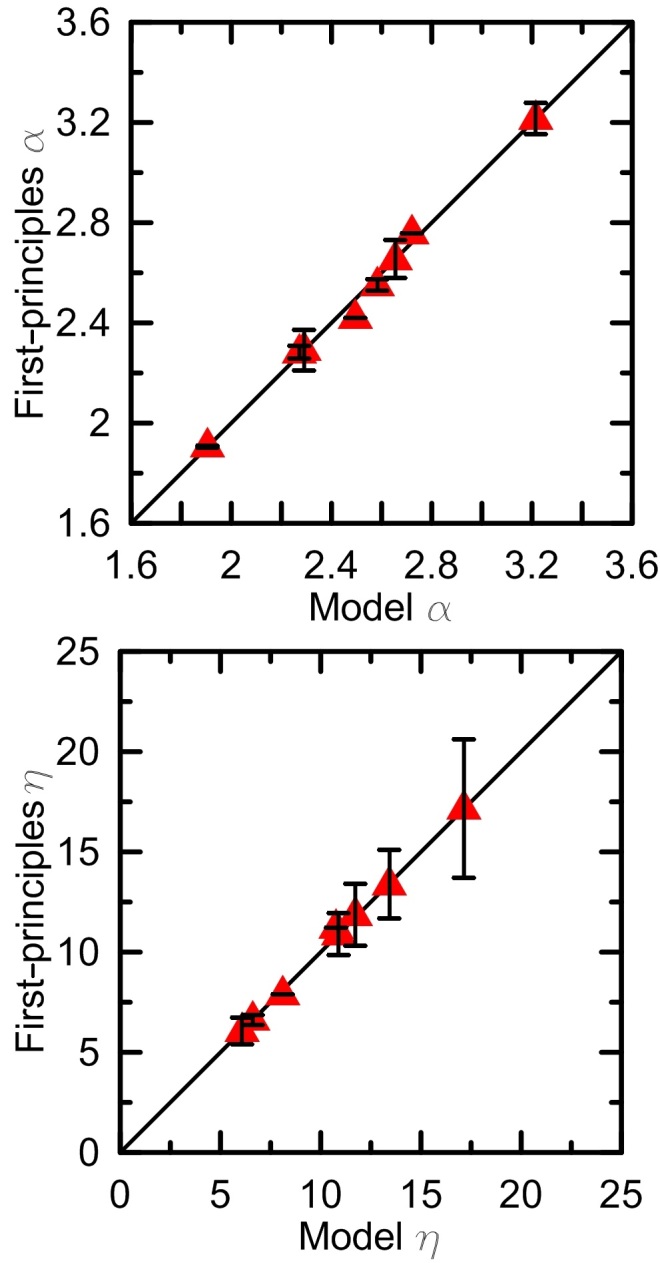
Characteristic parameters α and η.Comparison between characteristic parameters α (in Å3) and η (in Å3) of many MgO, Al2O3, and SiO2 phases calculated from DFPT and those derived from optimal αi and ηi values reported for coordination polyhedron i.